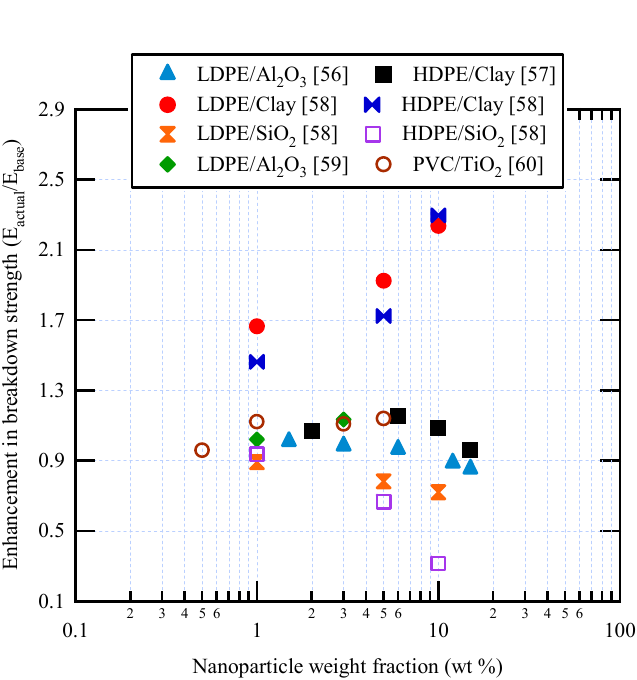
Figure 4. Some published data for AC breakdown strength in various polymer nanocomposites. There are two main factors responsible for the variability seen in these results. The